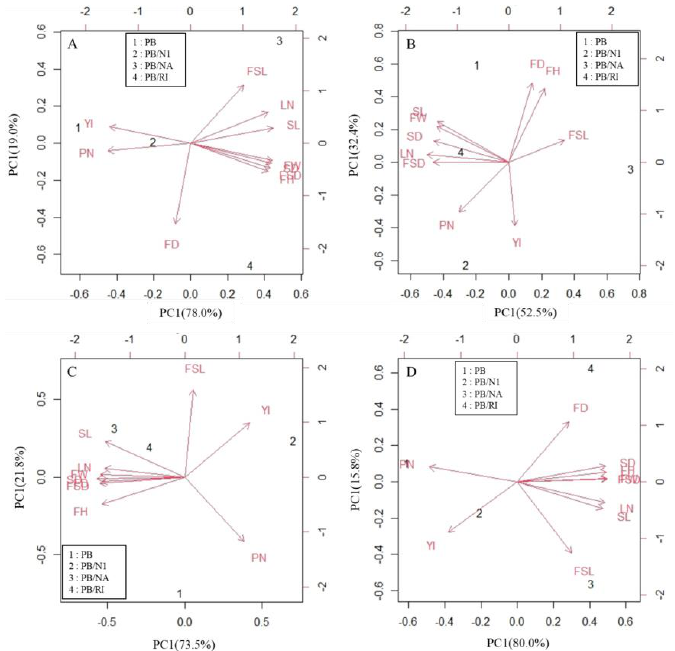
Figure 4. Biplot of the principal component analysis (PCA) of yield and growth of grafted standard type rose Rosa hybrida cv. Pink Beauty between rootstock types in four seasons based on the data in Table 1 with cutting and grafted rose being identified by numbers 1 to 4 and yield and growth parameter being identified by abbreviation. ( A ): spring; ( B ): summer; ( C ): autumn; ( D ): winter. PB: cutting on Rosa hybrida cv. Pink Beauty; PB/N1: Rosa hybrida cv. Pink Beauty grafted onto rootstock of Rosa multiflora cv. Hort No 1; PB/NA: Rosa hybrida cv. Pink Beauty grafted onto rootstock of Rosa canina cv. Natal brier; PB/RI: PB grafted onto rootstock of Rosa indica cv. Major. FD: flower diameter; FH: flower height; FSD: diameter of flower neck; FSL: length of flower neck; FW: fresh weight; LN: no. of leaves; PN: no. of petals; SD: stem diameter; SL: stem length; YI: yield of stem.